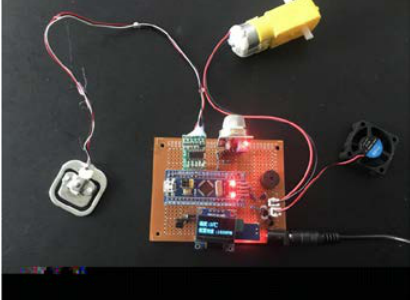
Fig. 10. Picture of actual